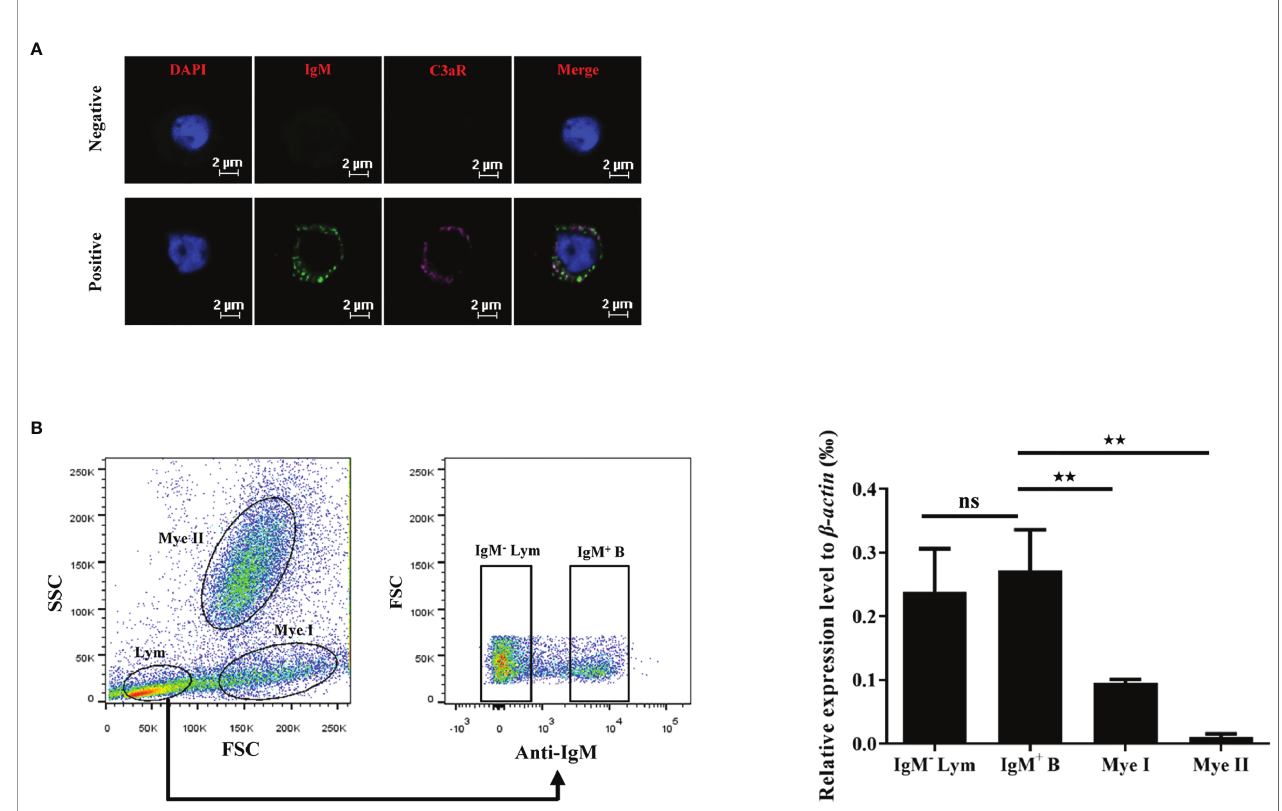
FIGURE 8 | C3aR is highly expressed by grass carp IgM + B cells. (A) Immuno fl uorescence microscopy of C3aR on IgM + B cells. HKLs were fi rst co-stained with mouse anti-grass carp IgM mAbs and rabbit anti-grass carp C3aR pAbs, then co-stained with Alex Flour 488-conjugated goat anti-mouse IgG (green for IgM) and Cy5-conjugated goat anti-rabbit IgG (magenta for C3aR). The mouse IgG isotype Abs and rabbit IgG isotype Abs were used as the negative controls. Nuclei were stained with DAPI (blue). One representative result was shown in the immuno fl uorescence images. Scale bars, 2 m m. (B) The mRNA expression pattern of C3aR in IgM + B cells, IgM - lymphocytes (Lym), subset I myeloid cells (Mye I), and subset II myeloid cells (Mye II). HKLs were stained with mouse anti-grass carp IgM mAbs, then cell populations including IgM + B cells, IgM - Lym, Mye I, and Mye II were sorted and subjected to RNA isolation and cDNA synthesis. The mRNA expression level of C3aR in the cell populations was analyzed by qPCR and normalized against the expression of b -actin using the 2 − D Ct method. One representative result was shown in the dot plot of fl ow cytometry. Data are presented as mean ± SEM (n = 4 fi sh), and the statistic p value was calculated by one-way ANOVA with a Dunnett post hoc test (ns, not signi fi cant; ** p <